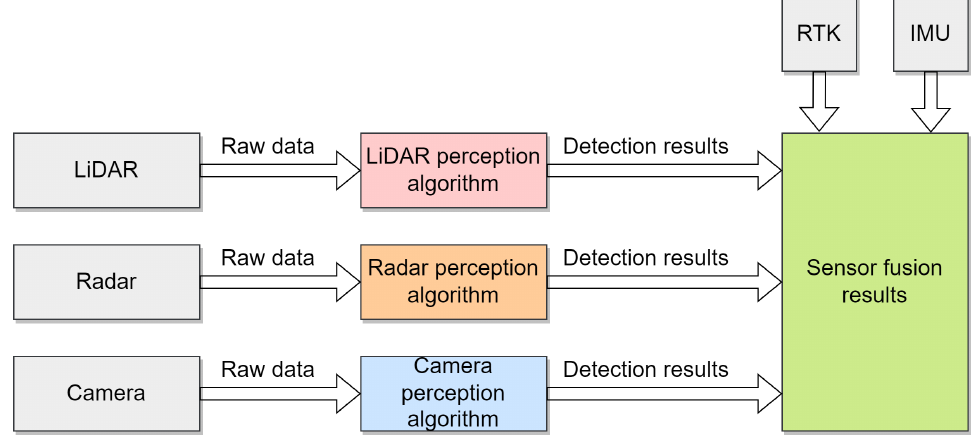
Figure 3. Typical architecture of late fusion algorithm.